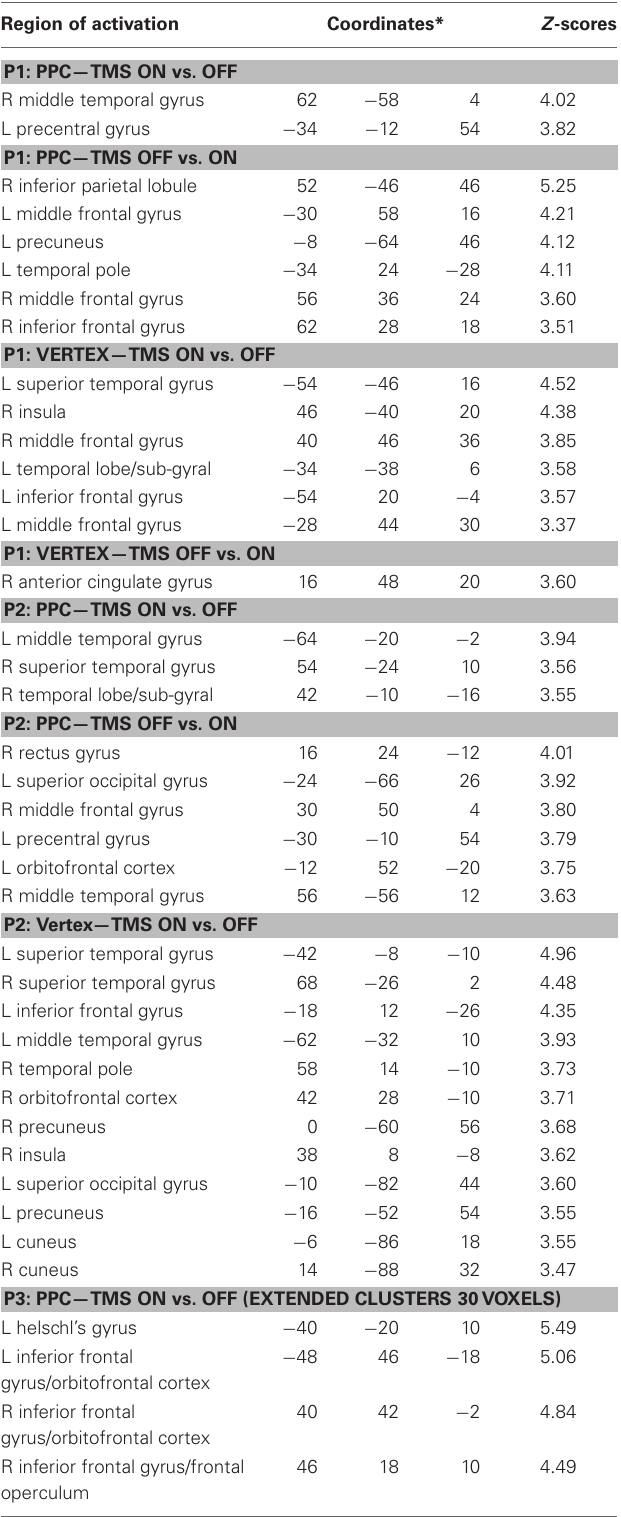
Table 2 | Individual comparisons of task execution with vs. without transcranial magnetic stimulation (TMS) for parietal (PPC) and vertex stimulation for Participants 1, 2, and 3 (P1, P2, and P3 respectively). Region of activation Coordinates* Z